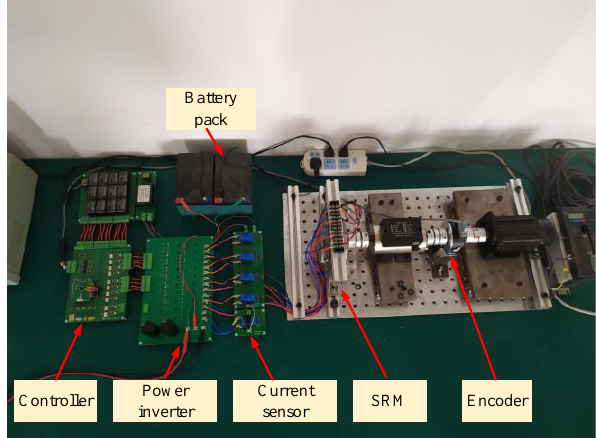
Figure 11. Experimental platform.